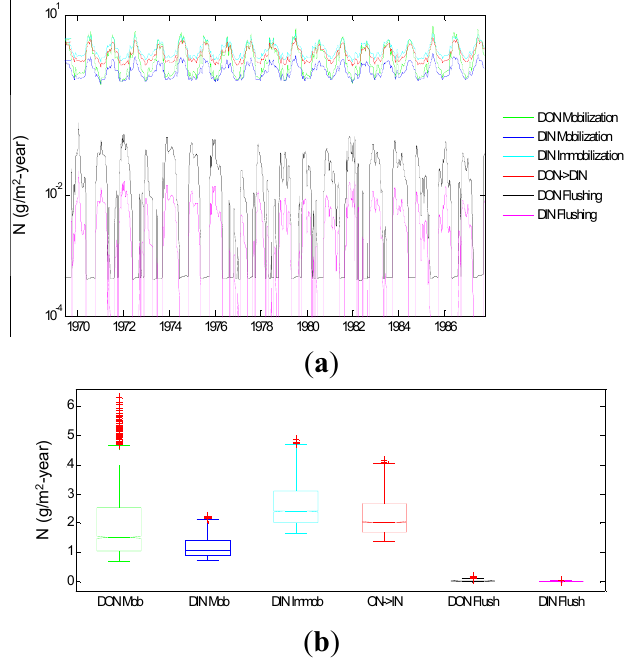
Figure 9. Key modeled rate terms associated with SOM processing occurring below the root zone. ( a ) The plot represents the modeled time series, as indicated in the legend, across the 20 year simulation time frame. These data are summarized and presented as a box and whisker plot ( b ). Note that the y axis is log transformed in the upper plot, but is linear in the lower